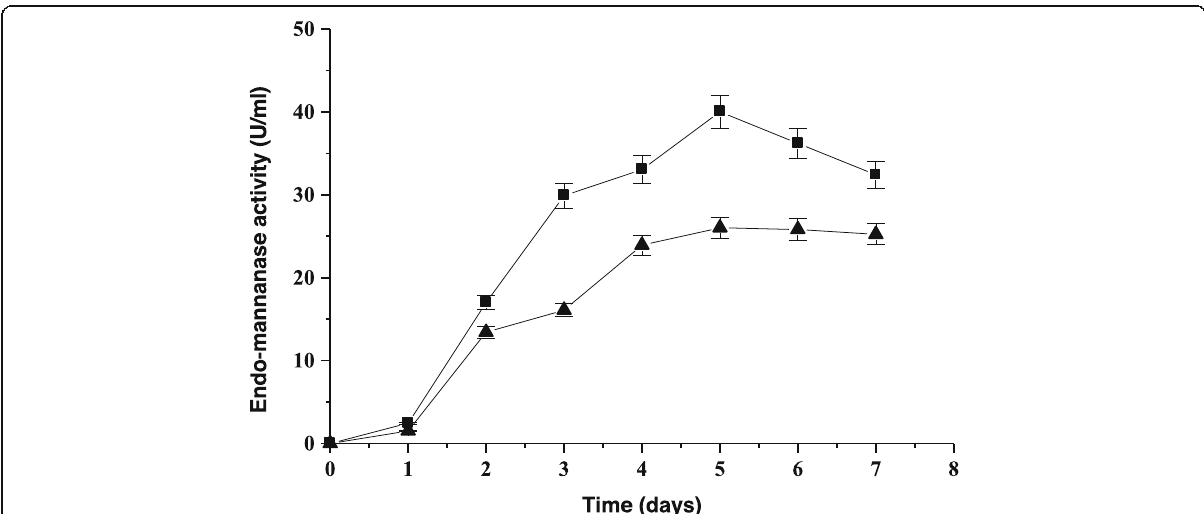
Fig. 2 Time course of endo- β -1, 4 mannanase production by Penicillium sp. in SmF on defatted copra meal before and after optimization (black square indicates optimized and black triangle, non-optimized)